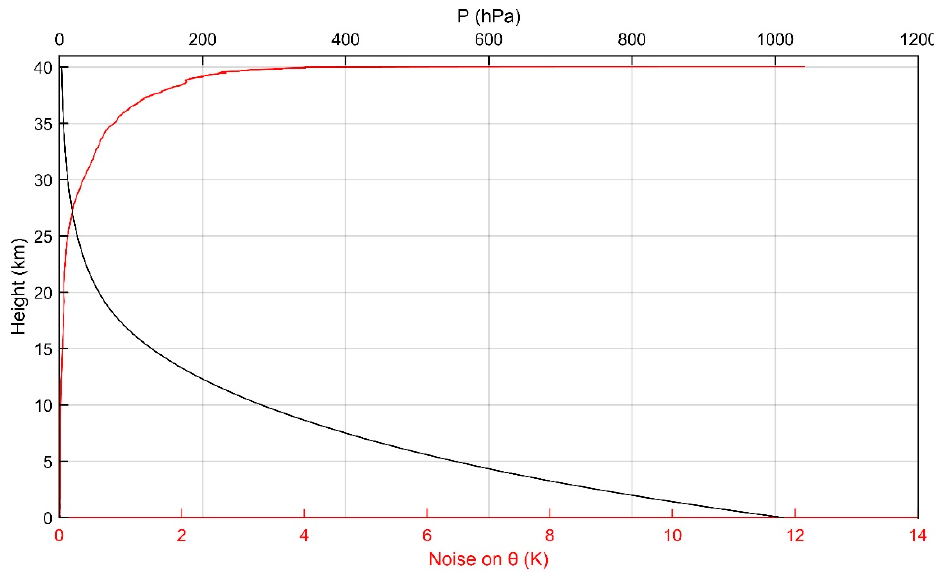
Figure 10. Vertical distribution of noise standard deviation and pressure.